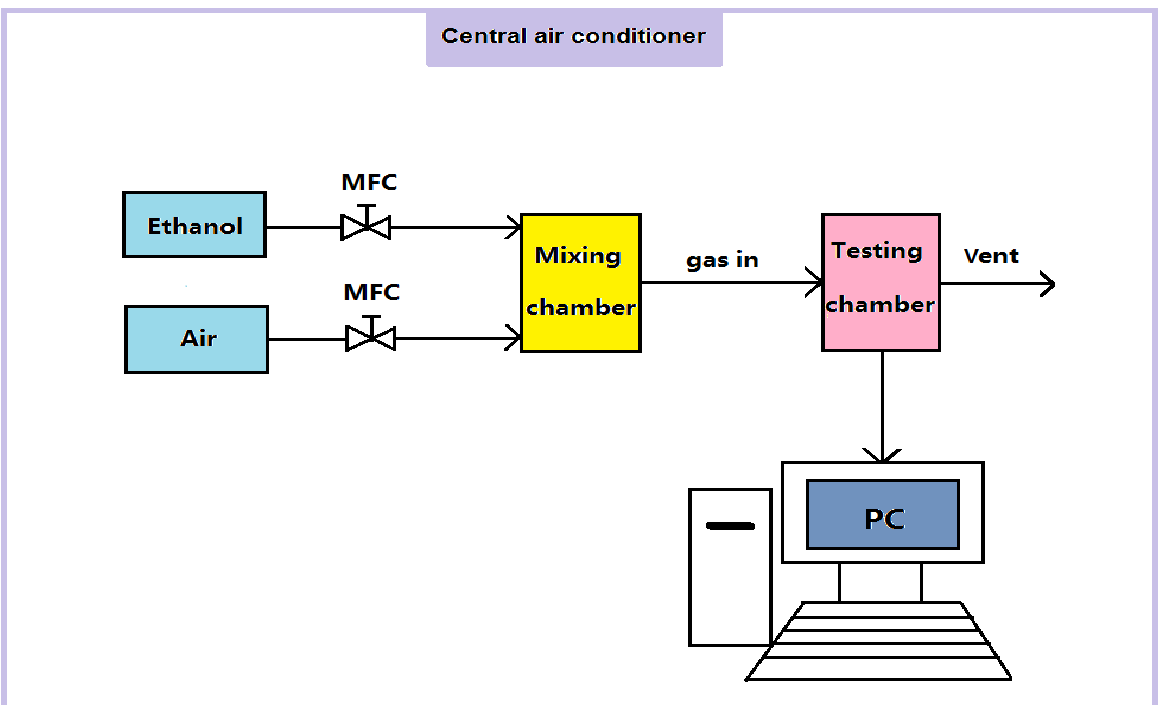
Figure 1. Gas sensing measurement